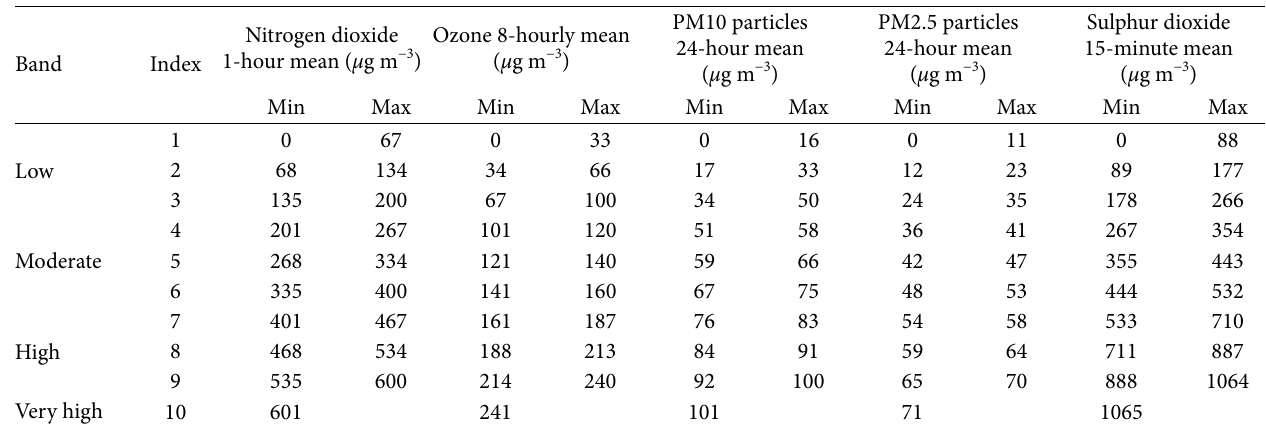
Table 4: The air quality